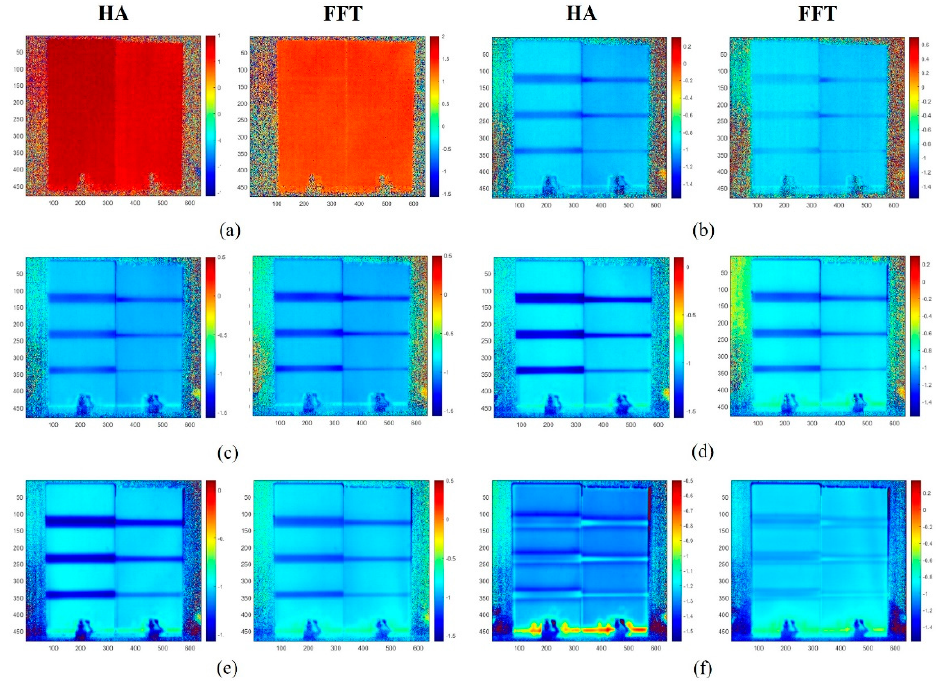
Figure 10. Processed images with HA and FFT algorithms for detecting defects in group 3 of samples at different modulation frequencies: ( a ) 1 Hz, ( b ) 0.2 Hz, ( c ) 0.1 Hz, ( d ) 0.05 Hz, ( e ) 0.03 Hz, and ( f ) 0.01 Hz.